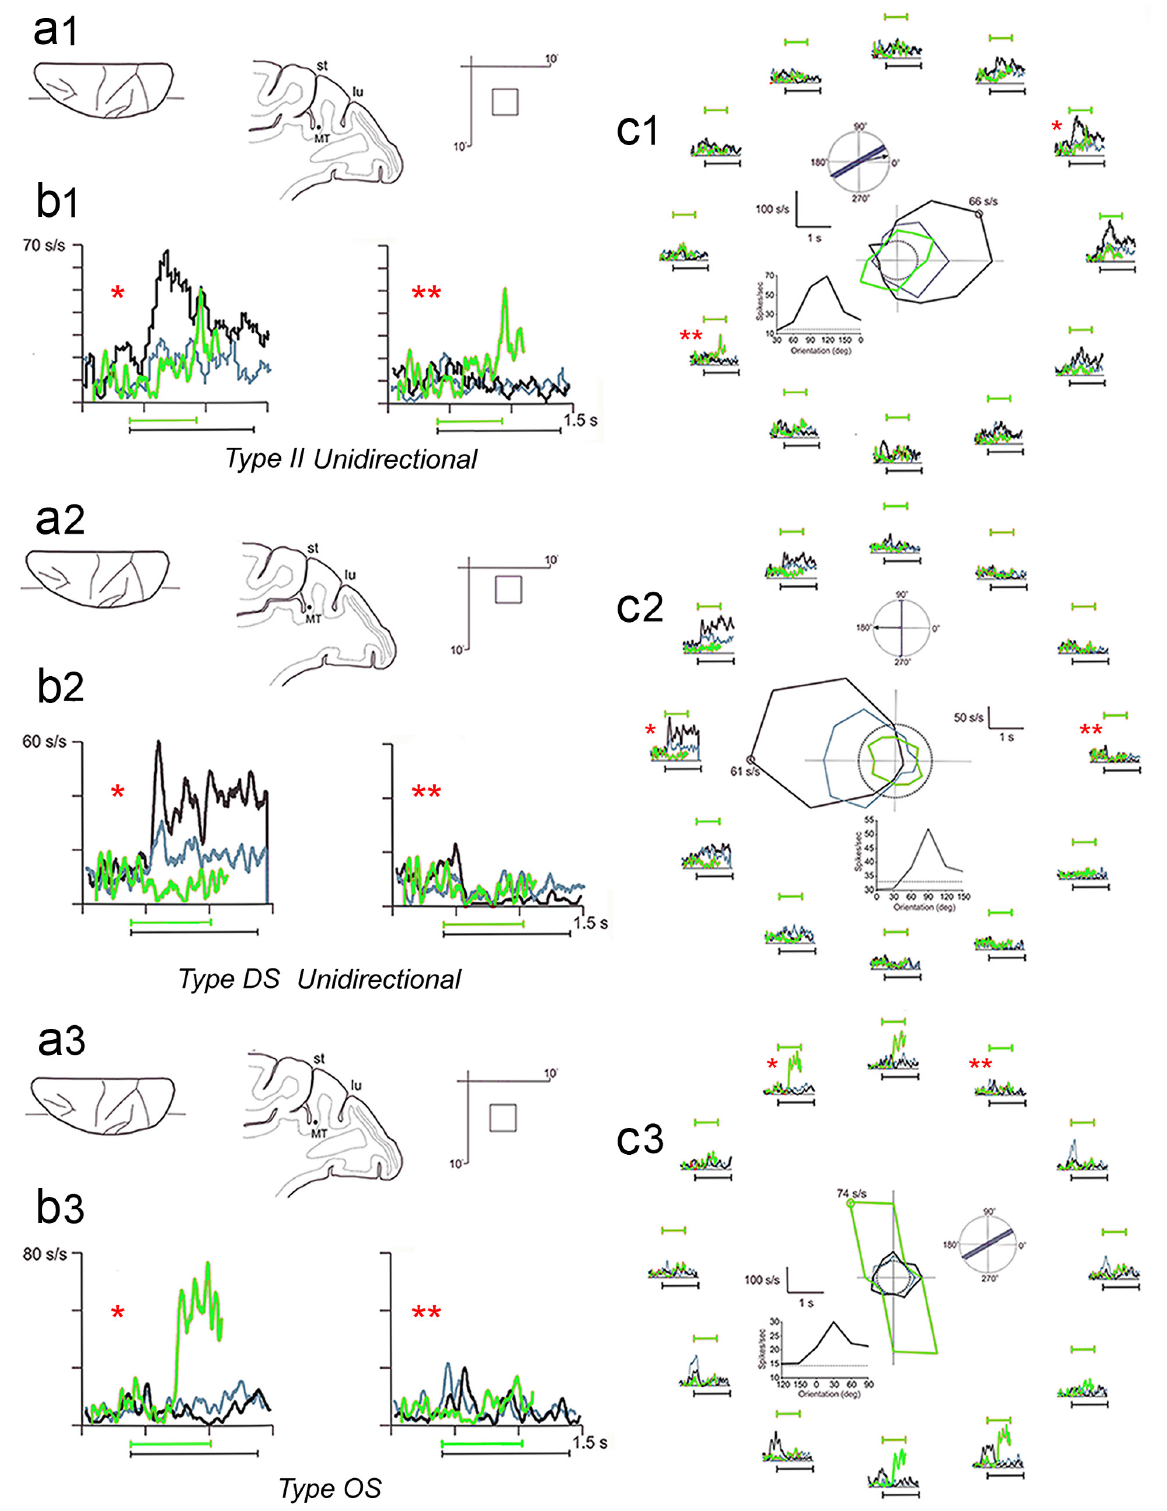
Figure 3. Examples of MT sites showing Type II unidirectional activity, Type DS unidirectional activity and Type OS activity (top, middle and bottom panels, respectively). Conventions as in Fig.